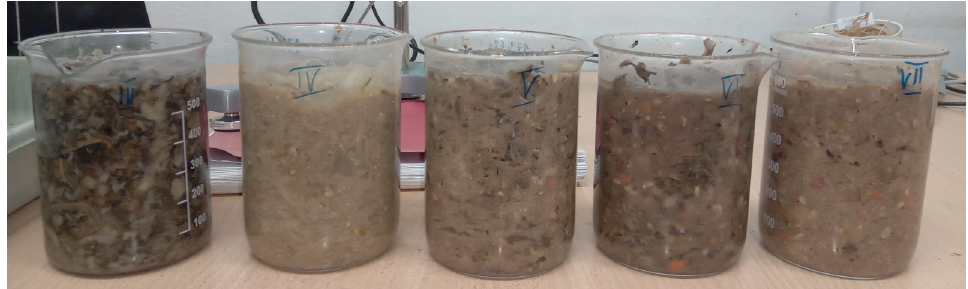
Figure 2. Samples III–VII before testing.